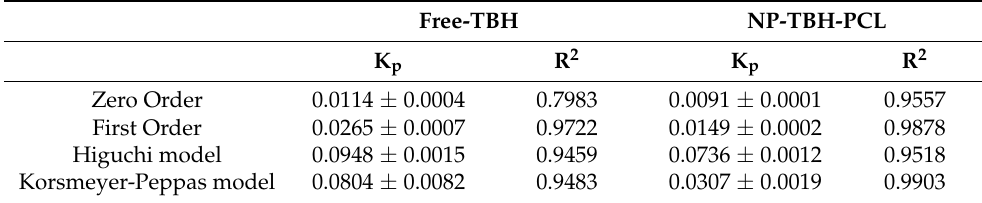
Table 3. Obtained kinetic parameters of the in vitro release profile of terbinafine.